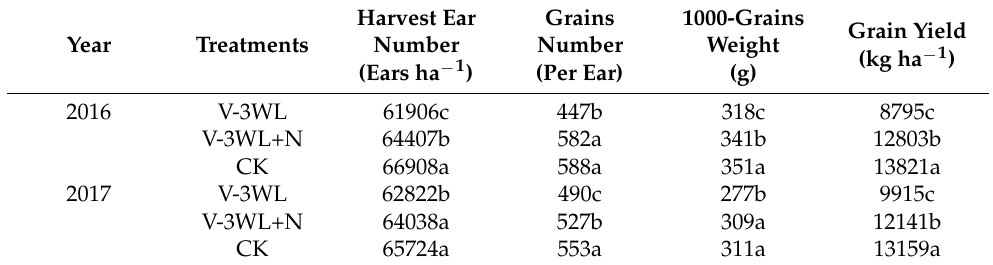
Table 1. Effects of applying nitrapyrin on grain yield and its components under a waterlogged field.